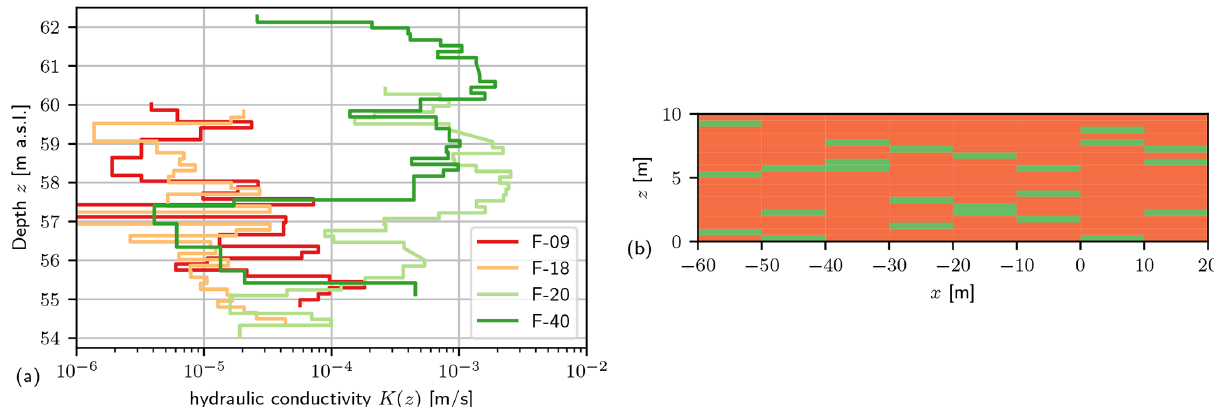
Figure 2. (a) Four flowmeter logs of hydraulic conductivity K(z) versus depth z . The logs F-09 and F-18 are close to the tracer test injection location, and F-20 and F-40 are several tens of metres downstream (see Fig. 3). (b) Concept of binary inclusion structure (Module B) with 15% high conductivity inclusions (green) embedded in the bulk of low conductivity (orange). Inclusion lengths are arbitrarily chosen to be I h = 5m and I v = 0 . 5 −